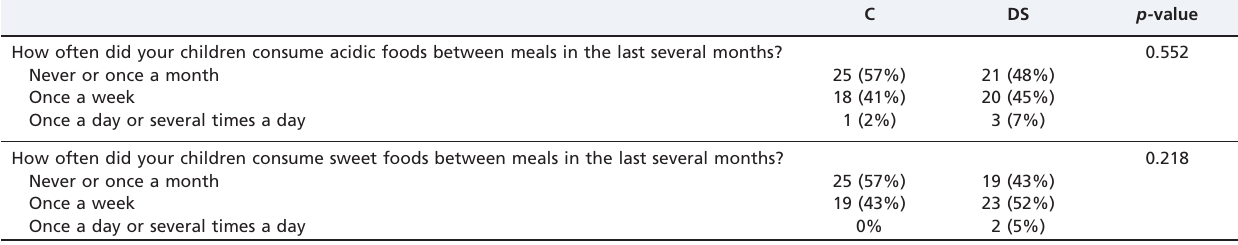
Table 1 - Dietary habits in Down Syndrome (DS) and sibling control (C) children, namely regarding the frequency of acidic or sweet food